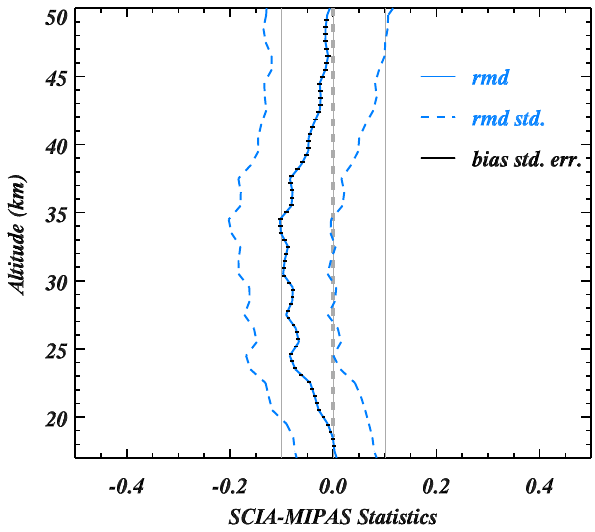
Fig. 16. SCIAMACHY–MIPAS comparison statistics for the period 2005–2010 based on 489